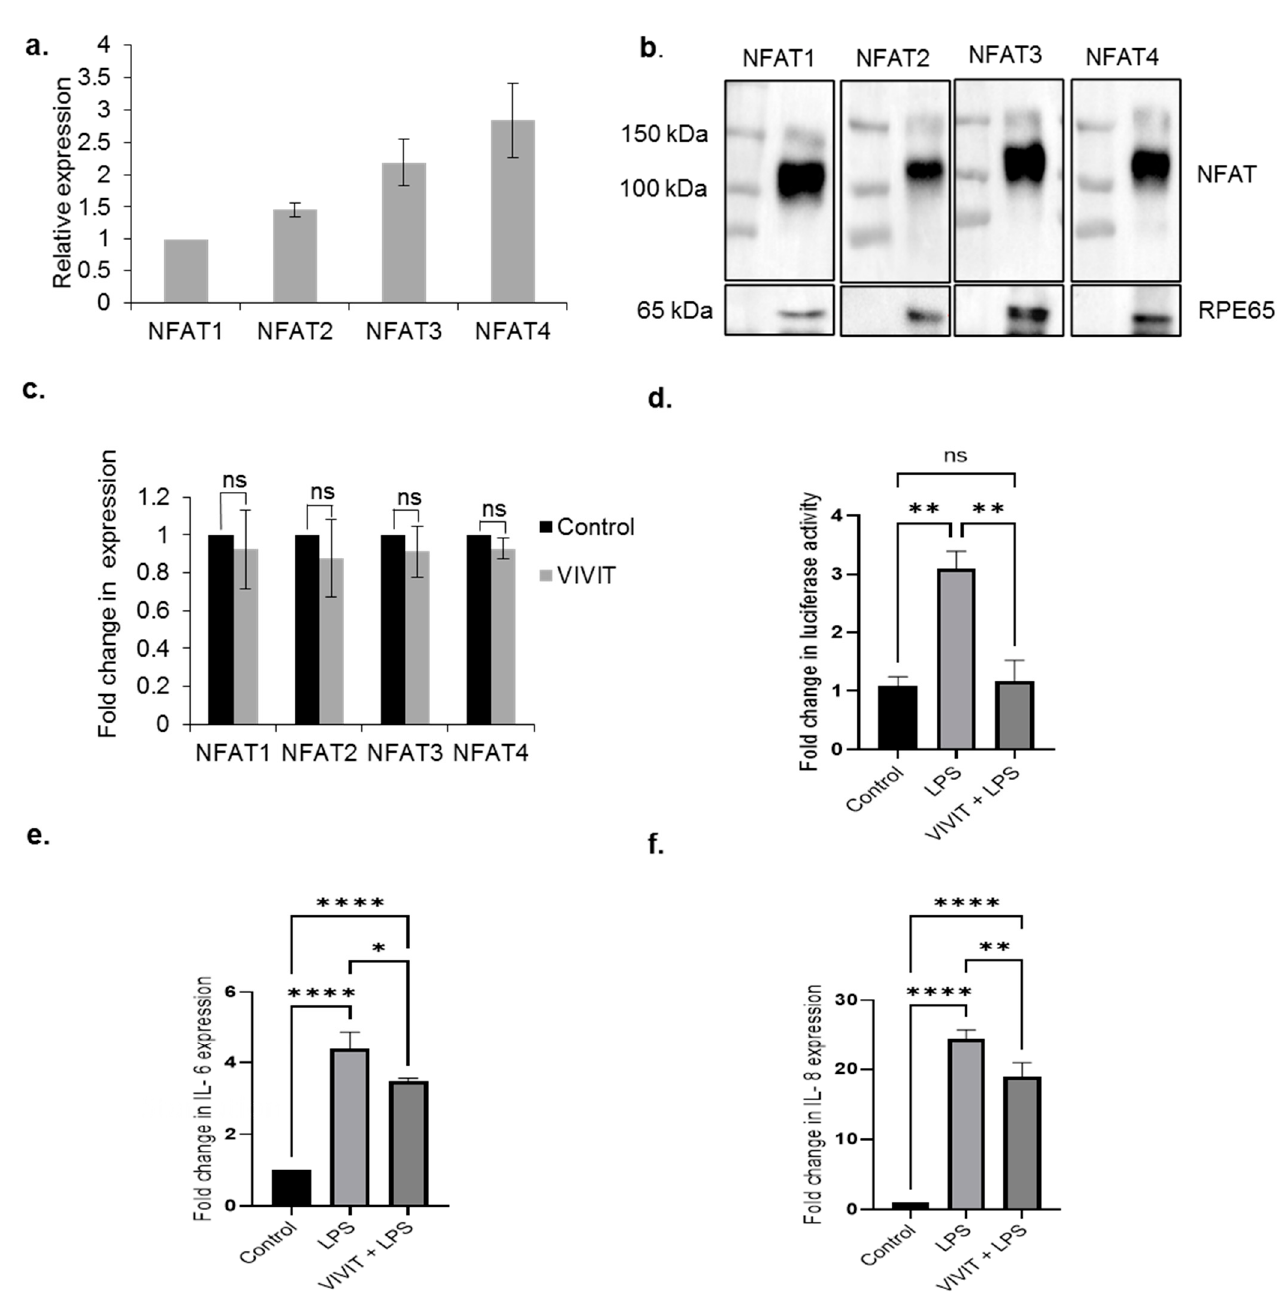
Figure 1. Expression of NFAT proteins in the RPE. ( a ) qRT-PCR analysis of the expression of NFAT isoforms in ARPE-19 cells. ( b ) Immunoblot analysis of the expression of NFAT isoforms, NFAT1-4 in isolated mouse RPE extracts. ( c ) Expression analysis of NFAT1-4 in ARPE-19 cells treated with 20 µM VIVIT for 48 h. Student’s t -test (two tailed) was used for statistical analysis. ( d ) Luciferase activity in AD-NFAT-luciferase vector transduced ARPE-19 cells treated with 10 µM VIVT for 4 h followed by treatment with 10 µg/mL LPS for 24 h. ( e ) qRT-PCR analysis of expression of IL-6 in ARPE-19 cells treated with 10 µM VIVIT followed by treatment with10 µg/mL LPS for 24 h. ( f ) qRT-PCR analysis of expression of IL-8 in ARPE-19 cells treated with 10 µM VIVIT followed by treatment with 10 µg/mL LPS for 24 h. Values represent mean ± s.d. of at least three independent experiments. One-way ANOVA was used for analysis p -value. The p -value is stated as * p < 0.05, ** p < 0.01, **** p < 0.0001.